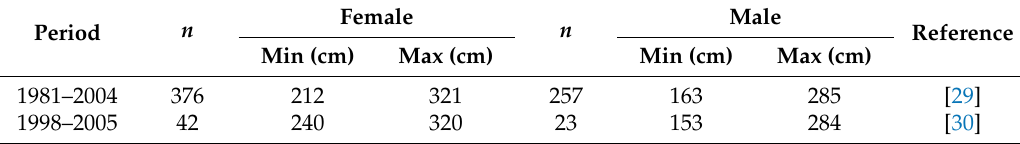
Table 3. Body lengths of adult Chinese sturgeons below the Gezhouba Dam in the Yangtze River.